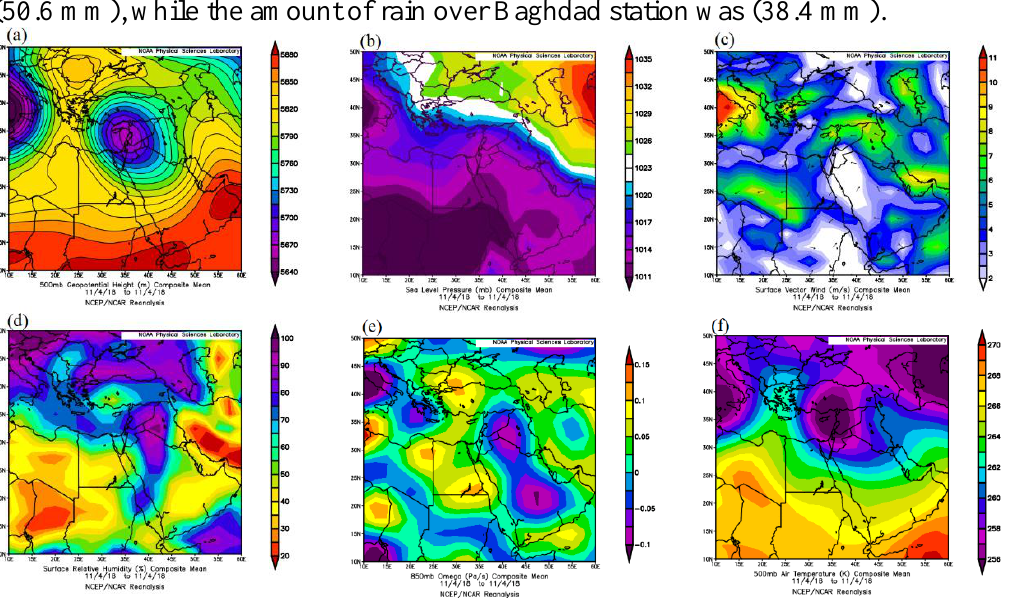
Figure 8: The weather chart for 4 November 2018, (a) 500 mb geopotential height (m), (b) sea level pressure (mb), (c) surface wind (m/s), (d) surface relative humidity (%), (e) 850 mb omega (pa/s), and (f) temperature (K) at 500 mb .